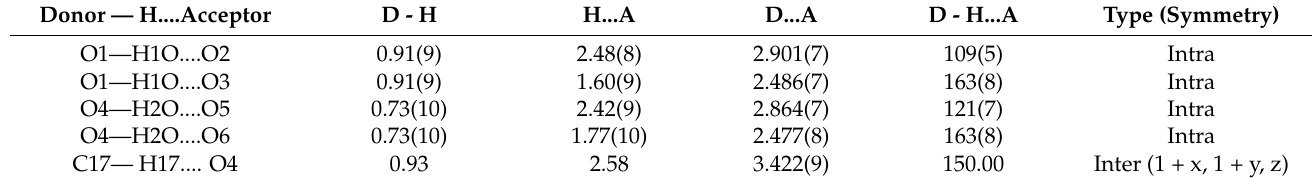
Figure 3. Crystal structure packing viewed down the b axis with hydrogen-bonding contacts shown as blue dashed lines.